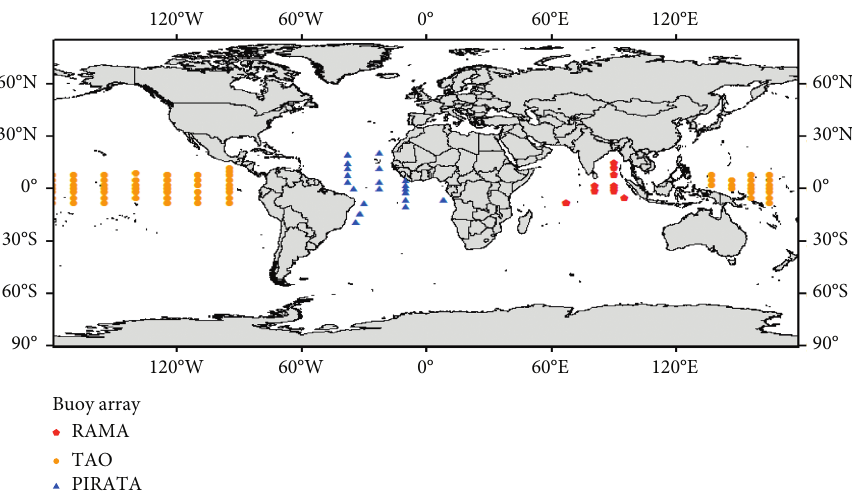
Figure 1: Locations of the 96 buoy sites used in this study.